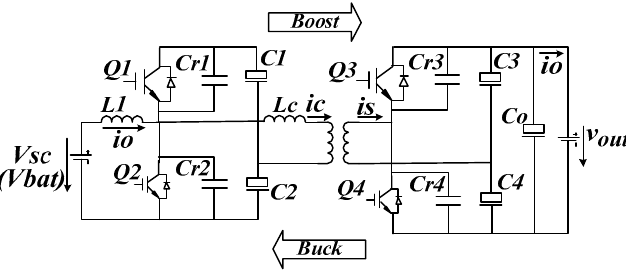
Figure 11. Isolated soft-switching symmetric half-bridge bidirectional converter.